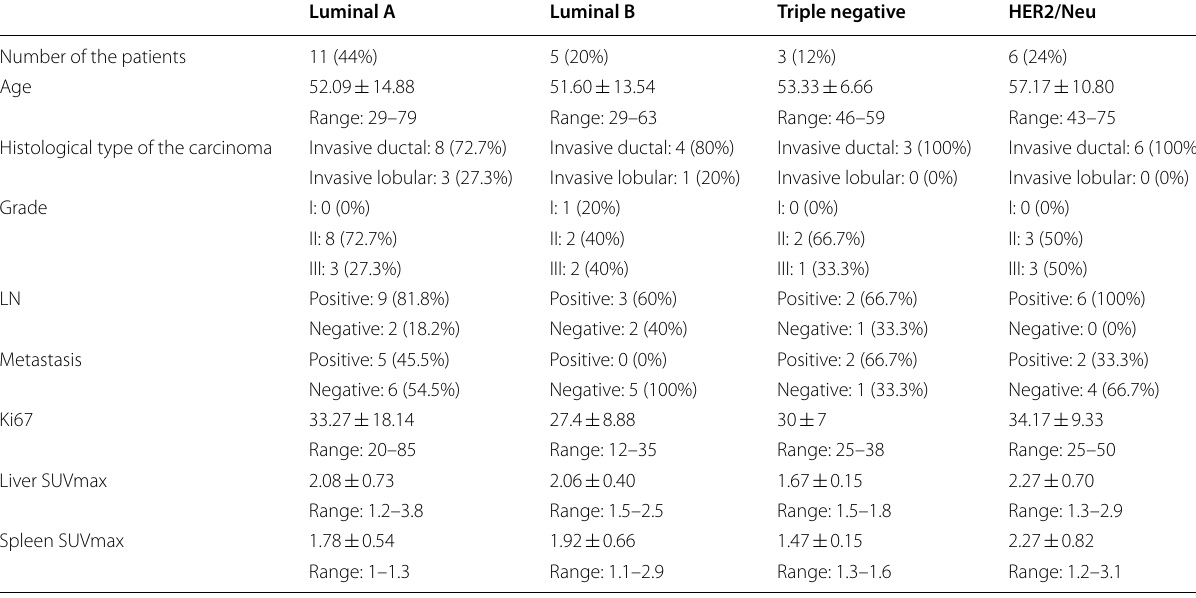
Table 3 Molecular subtypes, tumor characteristics and PET findings Luminal A Luminal B Triple negative Number of the patients